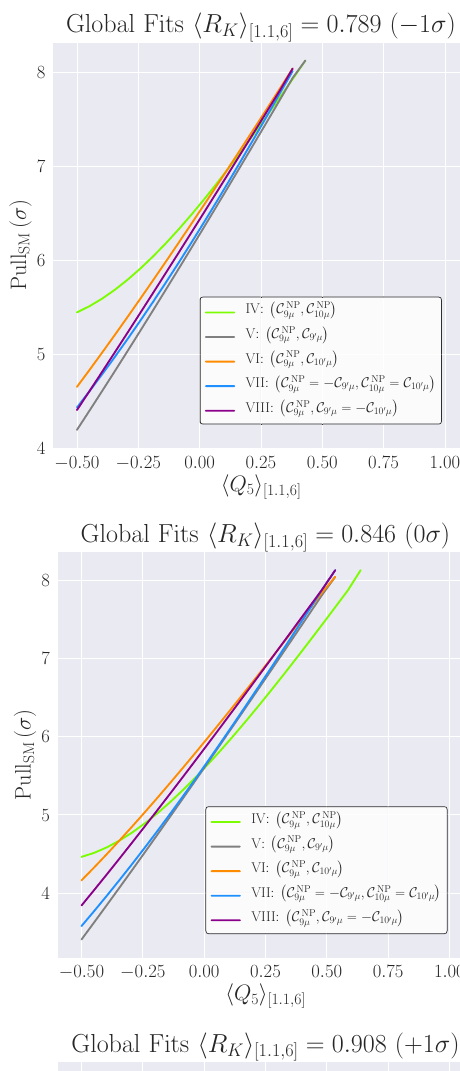
Figure 5. Global fit: impact of for different values of